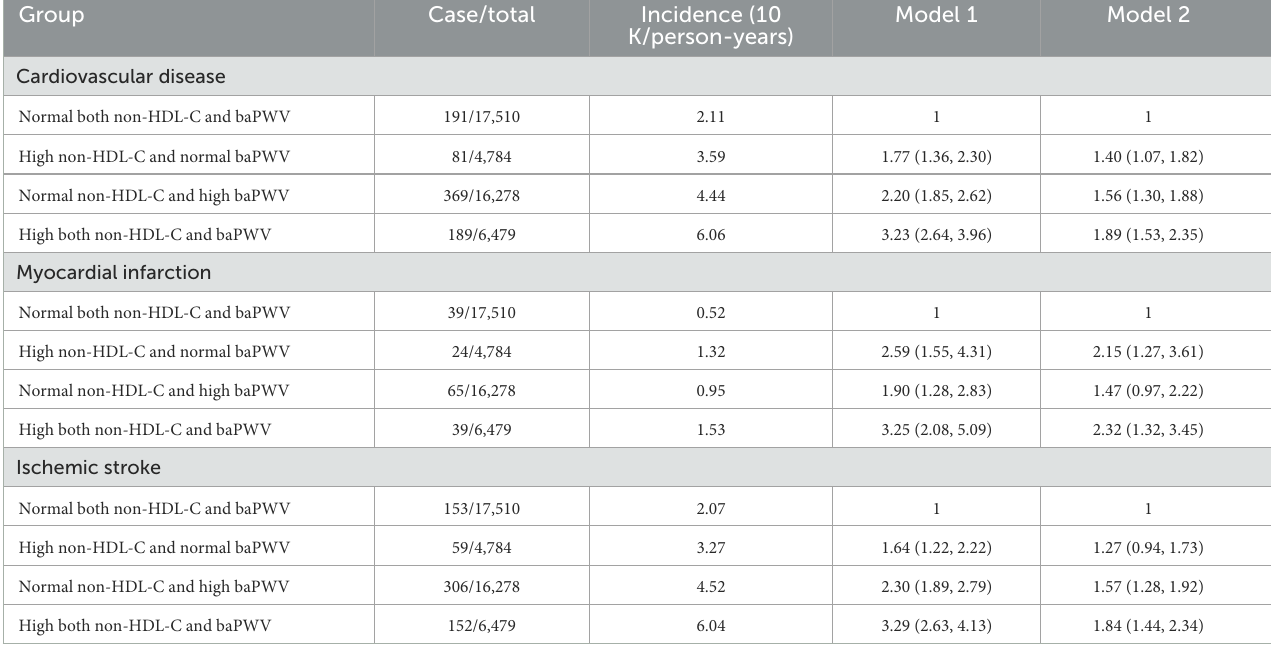
TABLE 3 Influence of combined effects of non-HDL-C and baPWV on